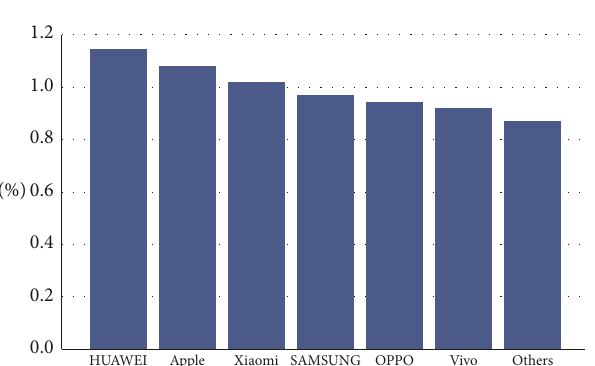
Figure 16: User behavior partition.